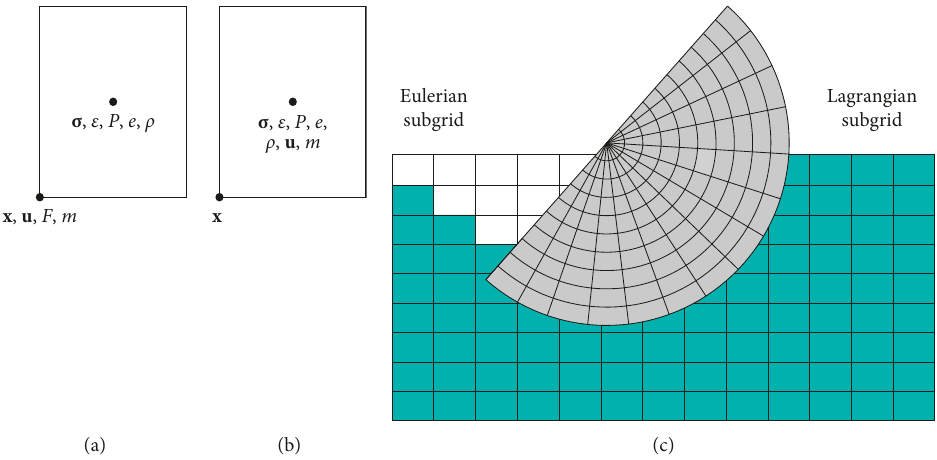
Figure 1: Calculation frame of the CEL method [25, 32].